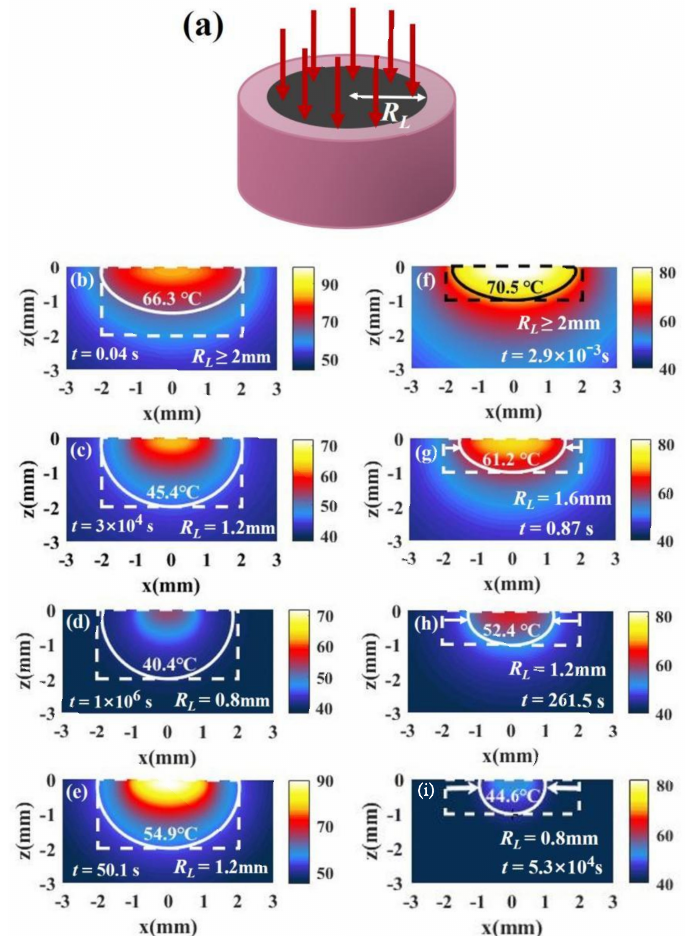
Figure 5. ( a ) Schematic of irradiation of a single spot light with a smaller radius than tissue radius ( R L < R T ). ( b – d ) The temperature distributions of a tumor and the surroundings irradiated with I = 15 W/cm 2 and under different irradiation radii for z/ RT = 1 ( R T = 2 mm, z = 2 mm). ( e ) The temperature distribution in case of R L = 1.2 mm and I = 30 W/cm 2 . ( f – i ) The temperature distributions with I = 15 W/cm 2 and under different irradiation radii in the case of z/ RT = 0.5 ( R T = 2 mm, z = 1 mm). The volume fraction is 5.6 × 10 − 6 ( f v = 5.6 × 10 − 6